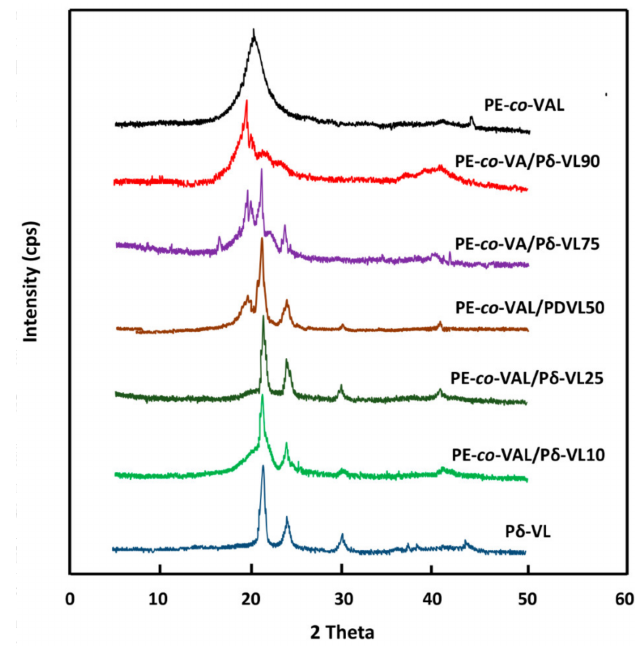
Figure 6. XRD patterns of PE- co -VAL, P δ -VL, and PE- co -VAL/P δ -VL blends with different compositions.